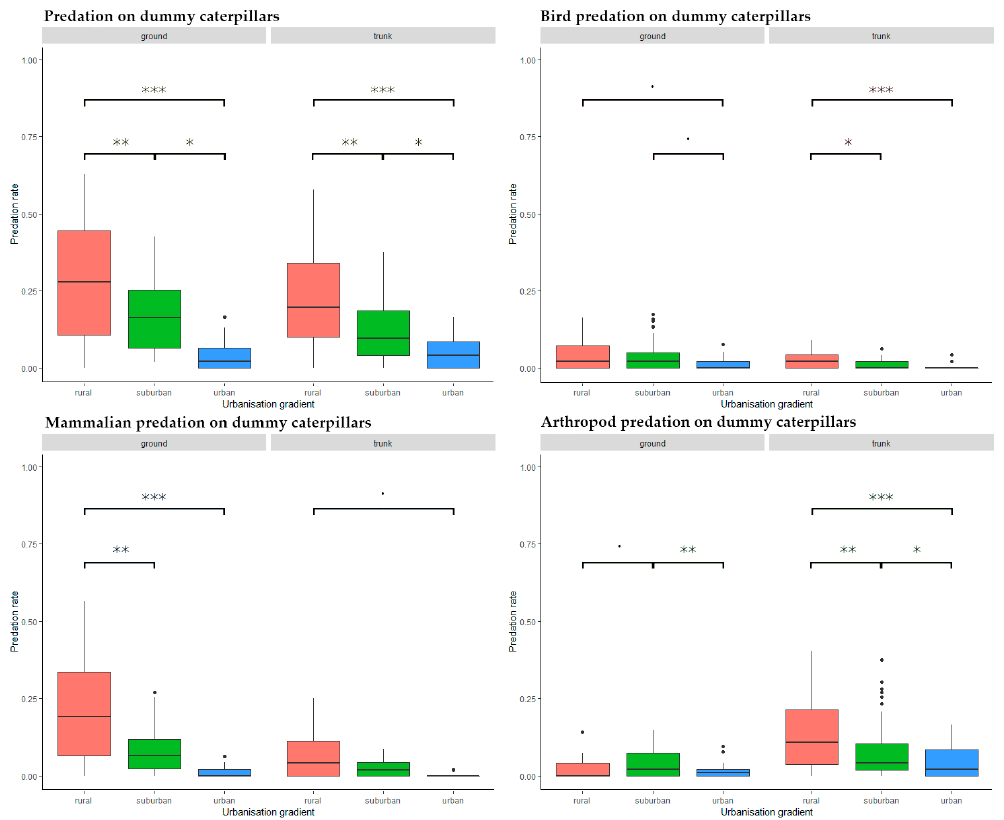
Figure 4. Predation activity along the urbanization gradient on different placement and by different predator groups. Significance codes: ***: p < 0.001, **: p < 0.01, *: p < 0.05, ˙ : p < 0.1.